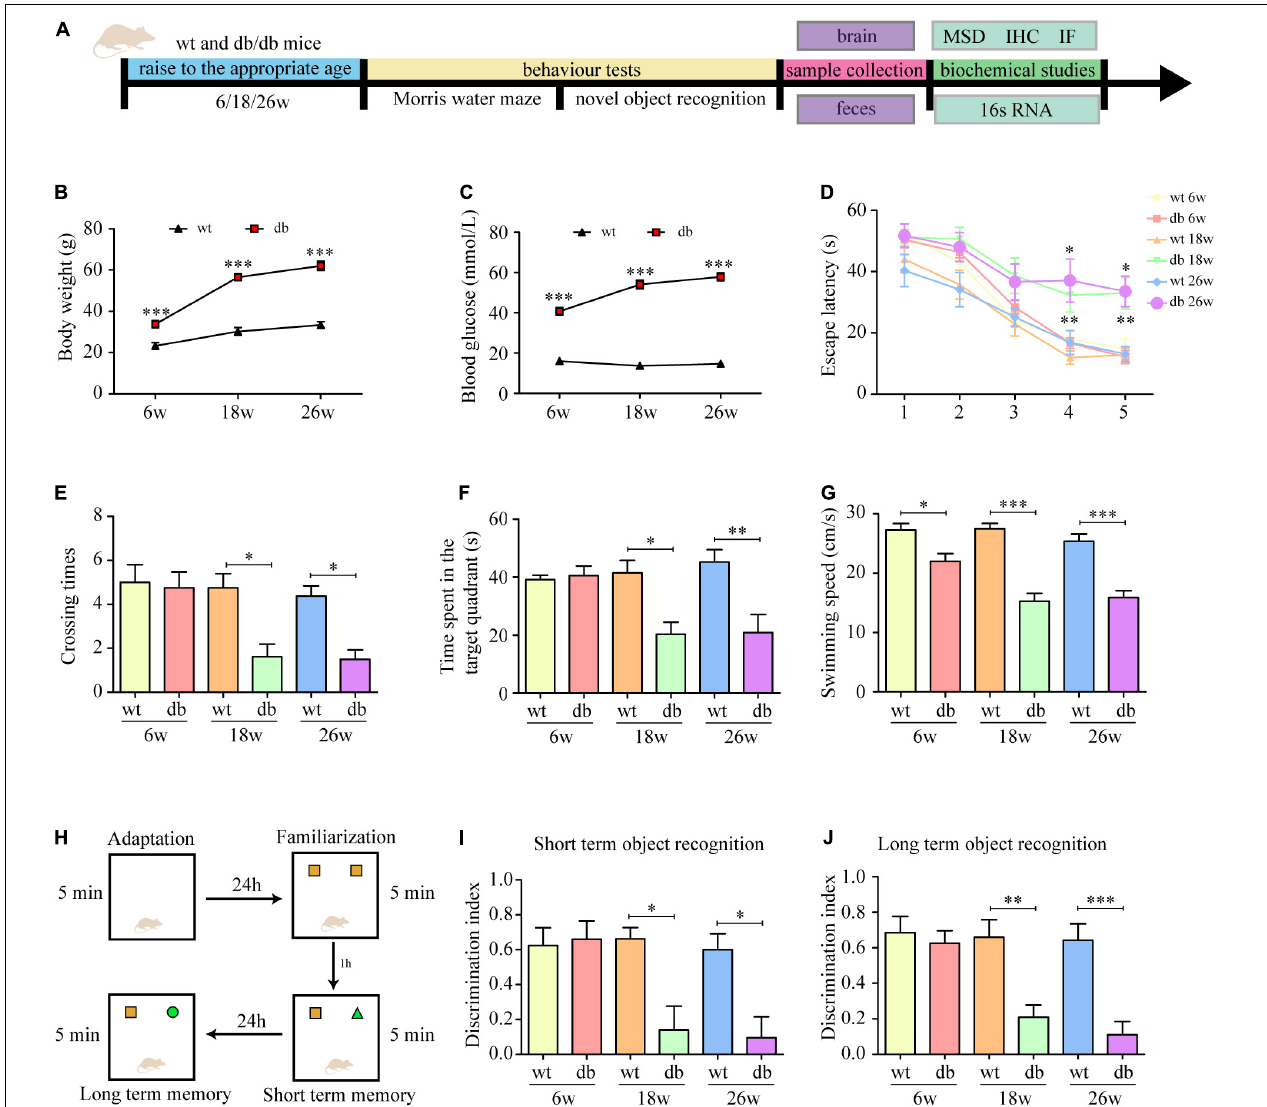
FIGURE 1 | Learning and memory performance was impaired in db/db mice. (A) Schematic diagram of the experimental procedure. (B) Body weight at different ages. (C) Blood glucose at different ages. (D) The escape latency of mice in the training trials of the hidden platform task. (E) Frequency of platform crossing in the probe trial. (F) Percentage of time spent in the target quadrant in the probe trial. (G) Swimming speed in the probe trial. (H) The experimental design of novel object recognition test. (I) The discrimination index of 1 h test trials. (J) The discrimination index of 24 h test trials. ( n = 8 per group); ∗ P < 0.05; ∗∗ P < 0.01; ∗∗∗ P <